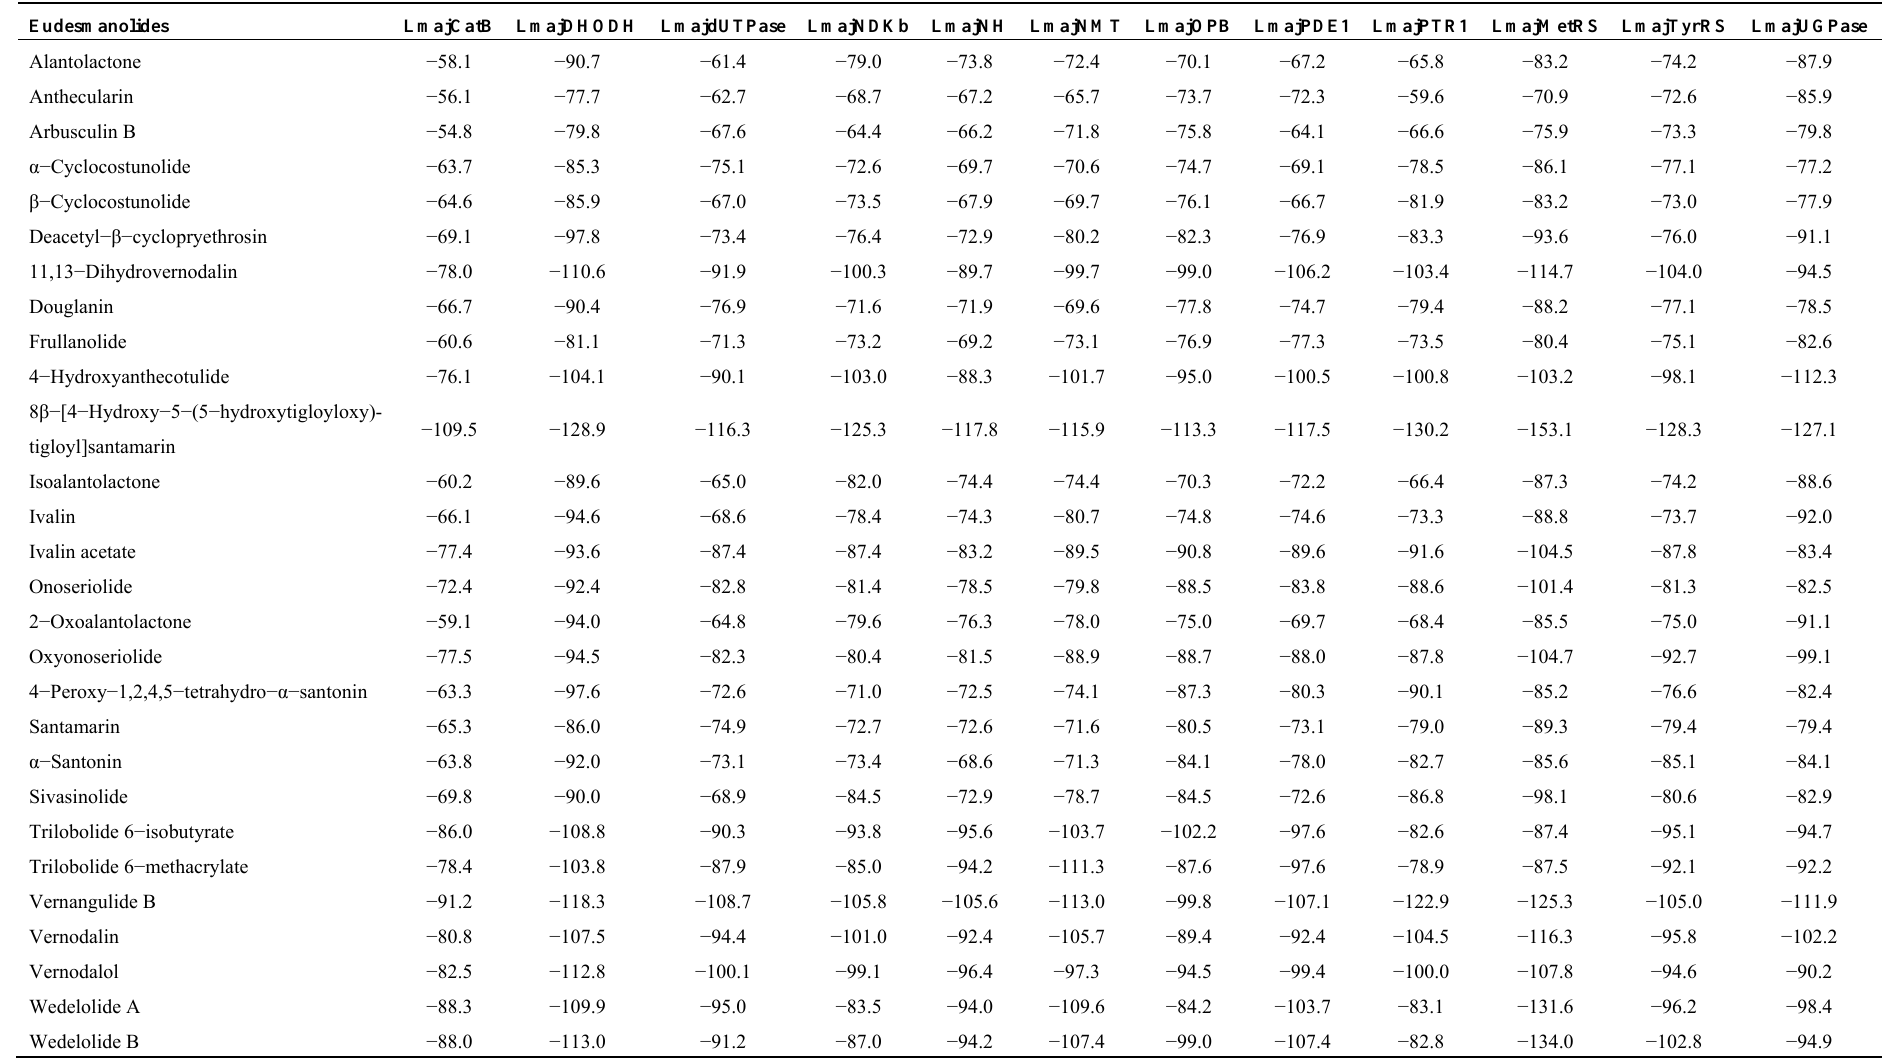
Table 10. MolDock docking energies (kJ/mol) of eudesmanolide sesquiterpenoids with Leishmania major protein